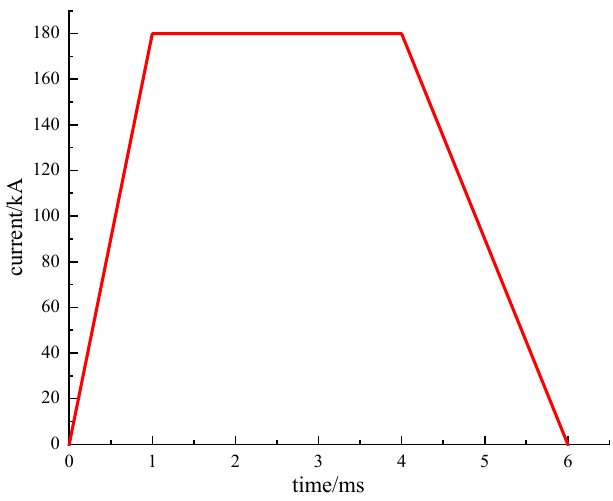
Figure 3. Transient simulation current diagram.